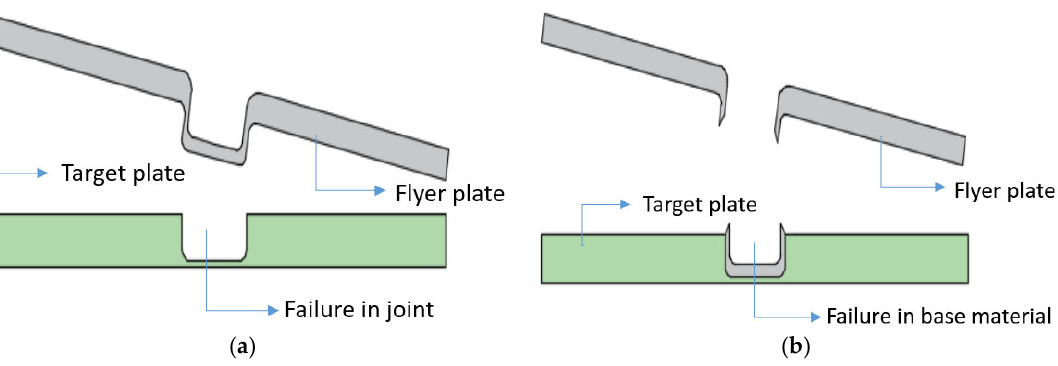
Figure 10. Two types of failure modes during peel tests: ( a ) separation failure and ( b ) crack failure.